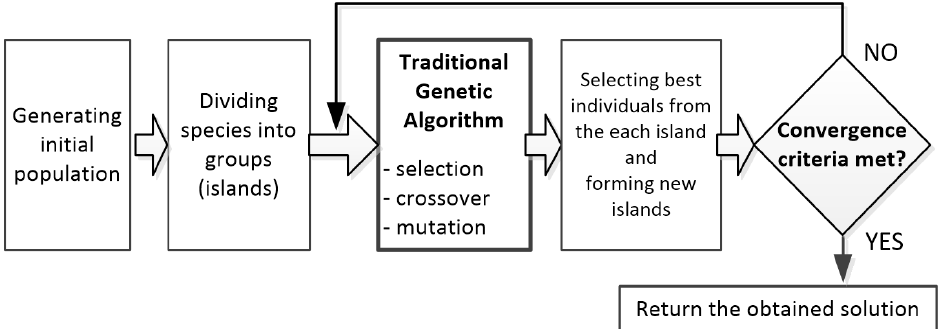
Figure 14. Combination of a surrogate model and multi-island genetic algorithm to optimize a high-speed valve by